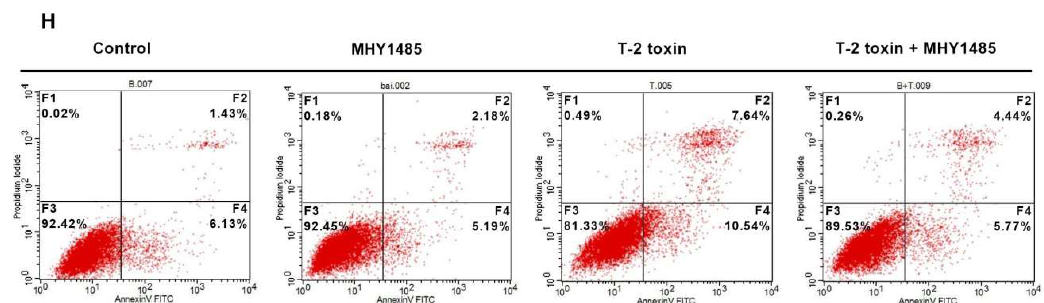
Figure 4. Mammalian Target of Rapamycin/Serine/Threonine Protein Kinase (mTOR/Akt) pathway inhibition is related to T-2 toxin-mediated apoptosis. T-2 toxin reduced the relative expression of p-mTOR ser 2481 ( A ), p-mTOR ser 2448 ( B ), and p-AKT ser 473 ( C ). MHY1485 attenuated the T-2 toxin-caused suppression of phosphorylation of mTOR at ser 2481 ( D ), ser 2448 ( E ), and AKT at ser 473 ( F ). MHY1485 inhibited free Ca 2+ intracellular concentration ( G ) and protected TM3 cells from apoptosis ( H , I ). * indicates p < 0.05 and ** indicates p < 0.01 when compared with the control group. ## indicated p < 0.01 when the co-treated group is compared with the group only treatment with T-2 toxin. Each experiment was performed and repeated at least three